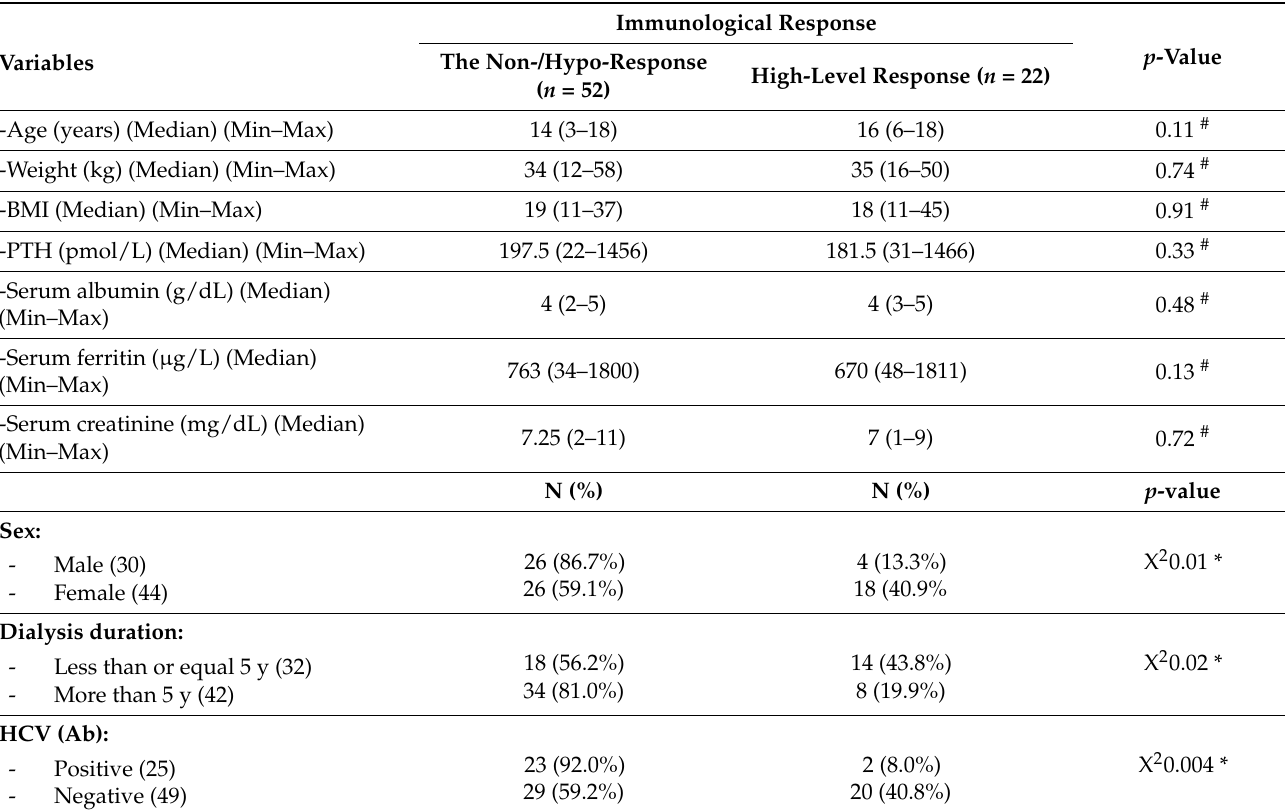
Table 3. Relation between some demographic and clinical characteristics and immunological response to hepatitis B vaccine among the sample studied.